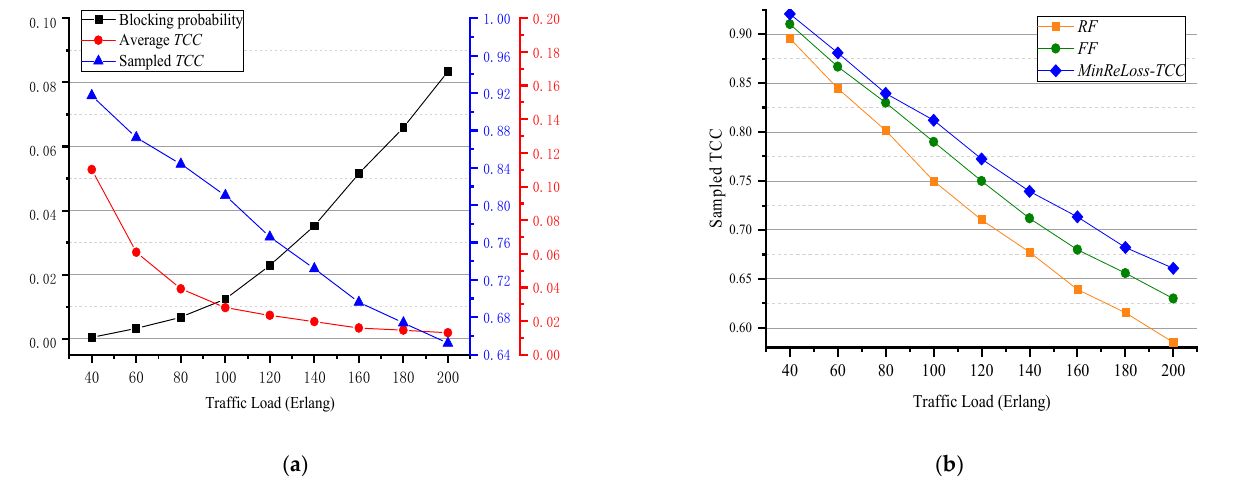
Figure 6. ( a ) Relationship among average TCC, sampled TCC, and blocking probability; ( b ) Sampled TCC under ReLoss- TCC-based RWTA, RF-based RWTA, and FF-based RWTA strategy.